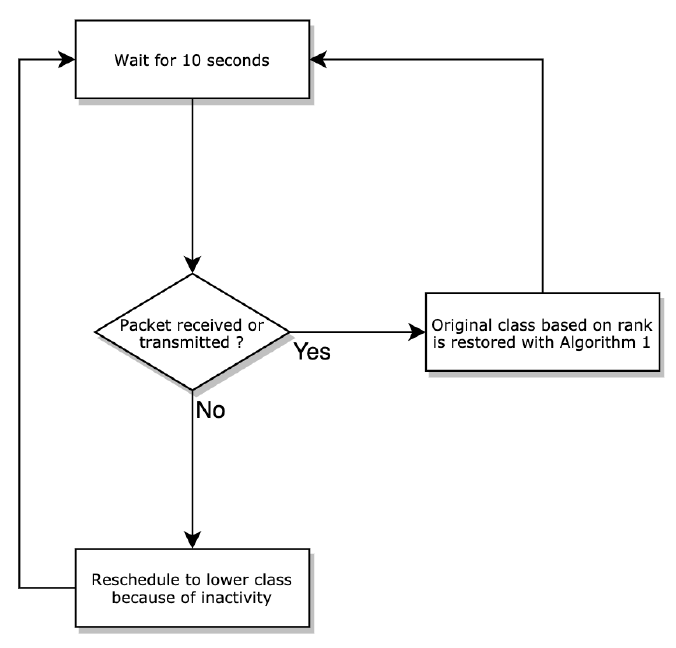
Figure 3. Algorithm 2 design flow